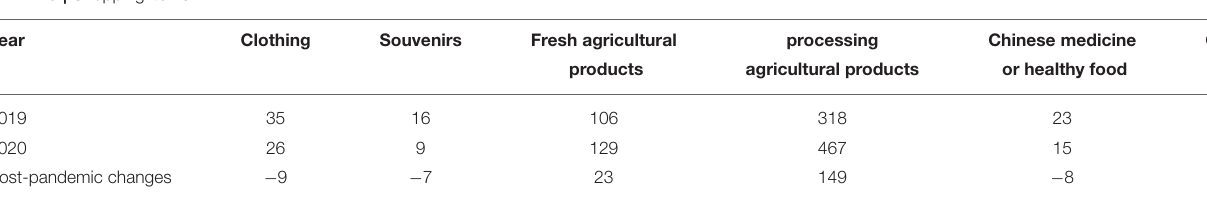
TABLE 9 | Shopping items.